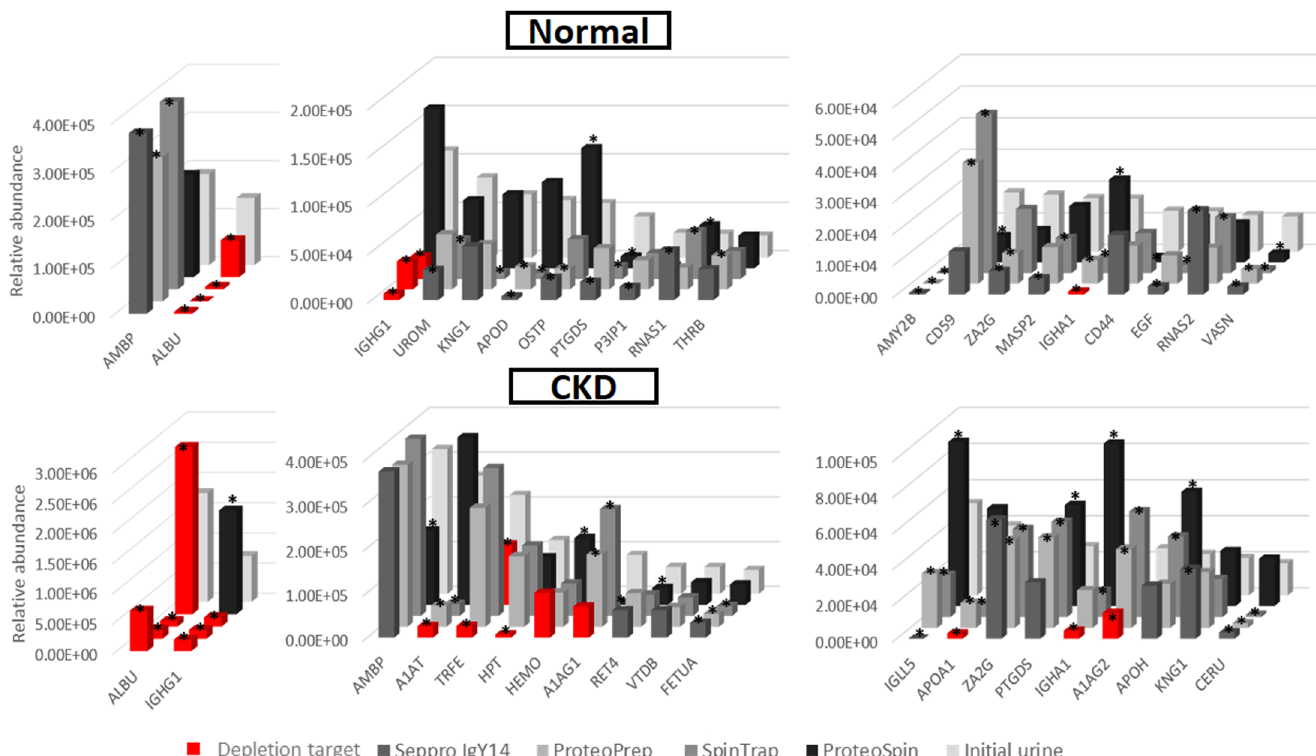
Fig 5. Relative abundance of 20 most abundant proteins derived from undepleted urine and comparison of their abundance with corresponding depleted fractions for urine from healthy controls and CKD patients. Efficient depletion of target proteins is observable for all methods, with the exception of albumin for ProteoSpin in CKD sample. * Denotes significant changes compared to initial urine. ABMP: protein AMBP, ALBU: albumin, IGHG1: Ig gamma-1 chain region, UROM: uromodulin, KNG1: kininogen 1, APOD: apolipoprotein D, OSTP: osteopontin, PTGDS: prostaglandin-H2 D-isomerase, P3IP1: phosphoinositide-3-kinase-interacting protein 1, RNAS1: ribonuclease pancreatic, THRB: prothrombin, AMY2B: alpha-amylase 2B, CD59: CD59 glycoprotein, ZA2G: zinc-alpha-2-glycoprotein, MASP2: mannan-binding lectin serine protease 2, IGHA1: Ig alpha-1 chain C region, CD44: CD44 antigen, EGF: pro-epidermal growth factor, RNAS2: non-secretory ribonuclease, VASN: vasorin, A1AT: alpha-1-antitrypsin, TRFE: serotransferrin, HPT: haptoglobin, HEMO: hemopexin, A1AG1: alpha-1-acid glycoprotein 1, RET4: retinol-binding protein 4, VTDB: vitamin D-binding protein, FETUA: alpha-2-HS- glycoprotein, IGLL5: immunoglobulin lambda-like polypeptide 5, APOA1: apolipoprotein A-I, A1AG2: alpha-1-acid glycoprotein 2, APOH: beta-2-glycoprotein 1, CERU: ceruloplasmin.